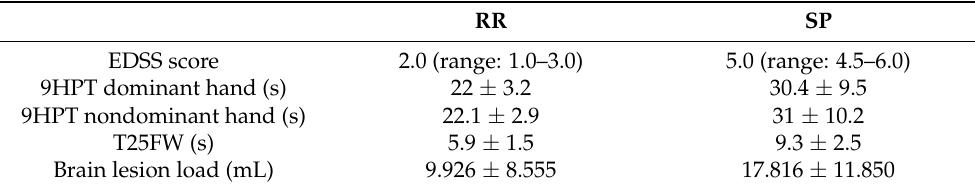
Table 2. Relapsing–remitting and secondary progressive patients’ clinical and radiological features at